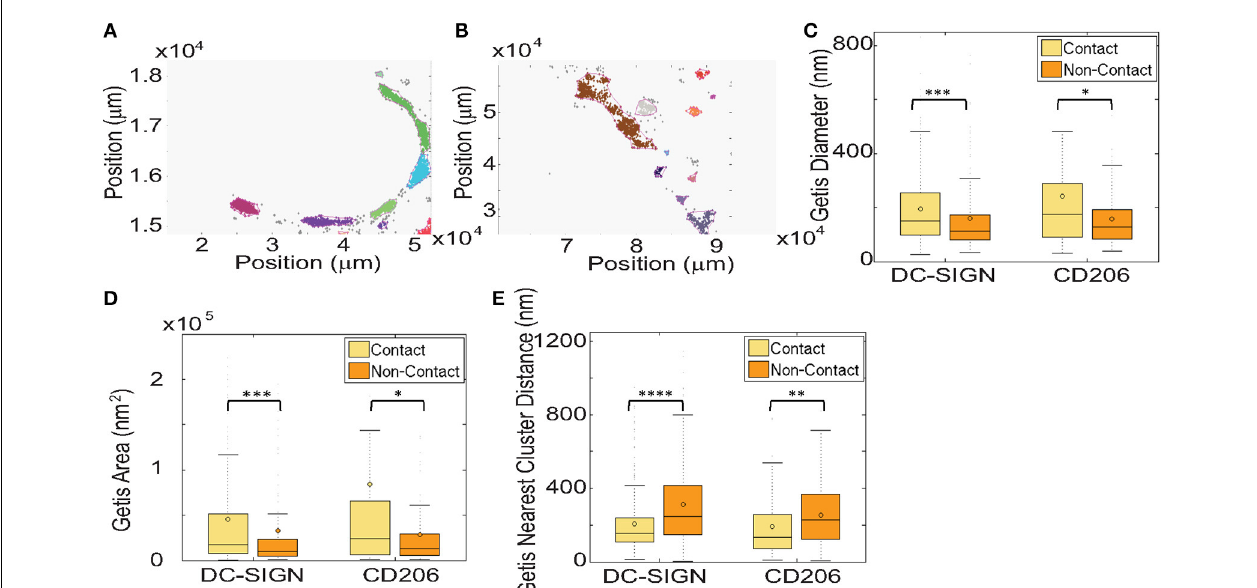
FIGURE 4 | Getis statistical analysis of clustering and local density in fungal contact regions on dendritic cells. (A) A representative map of clusters of CD206 identified using Getis in a zymosan contact ROI on a dendritic cell with a zymosan particle bound. Different colors represent independent clusters identified by the algorithm. (B) A representative map of clusters of CD206 in a non-contact ROI on the same cell as in (A) . Getis G values are calculated on 10 × 10nm square regions. (C) Box and whisker plot of the cluster diameters from Getis analysis. The mean value is depicted by the shaded circle, the median value is depicted by the horizontal line in the shaded box, which represents the Interquartile Range (IQR, values from 25th–75th percentile). The bars above and below the shaded box denote positions 1.5 times the IQR above the 75th percentile and 1.5 times below